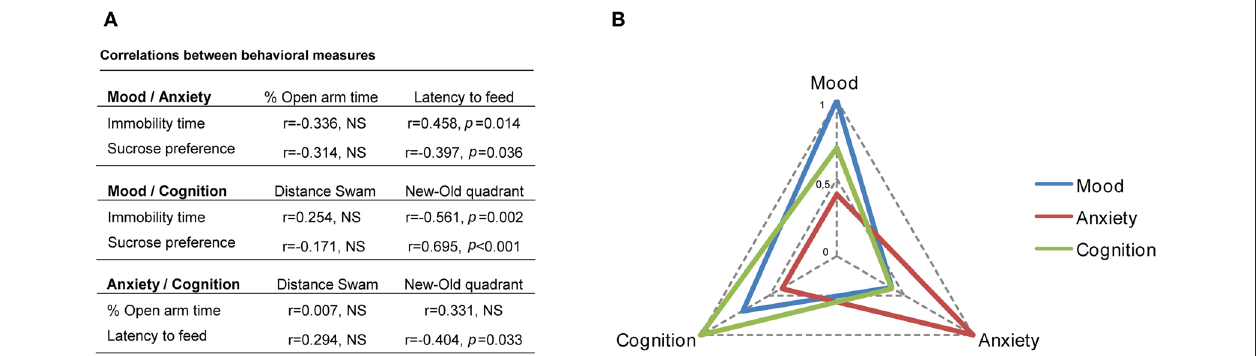
FIGURE 3 | Inter-domain correlations between mood, anxiety and cognition. (A) Table shows Pearson correlation coeffi cients between different behavioral parameters and (B) graphical representation of the correlations between mood (sucrose preference), anxiety (latency to feed) and cognition (new–old quadrant